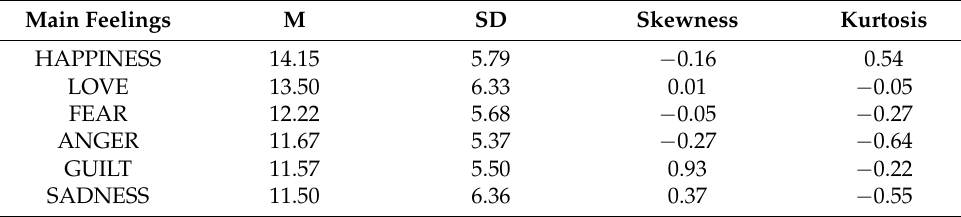
Table 7. Descriptive statistics for the main emotions in the group of inmates (N = 250).